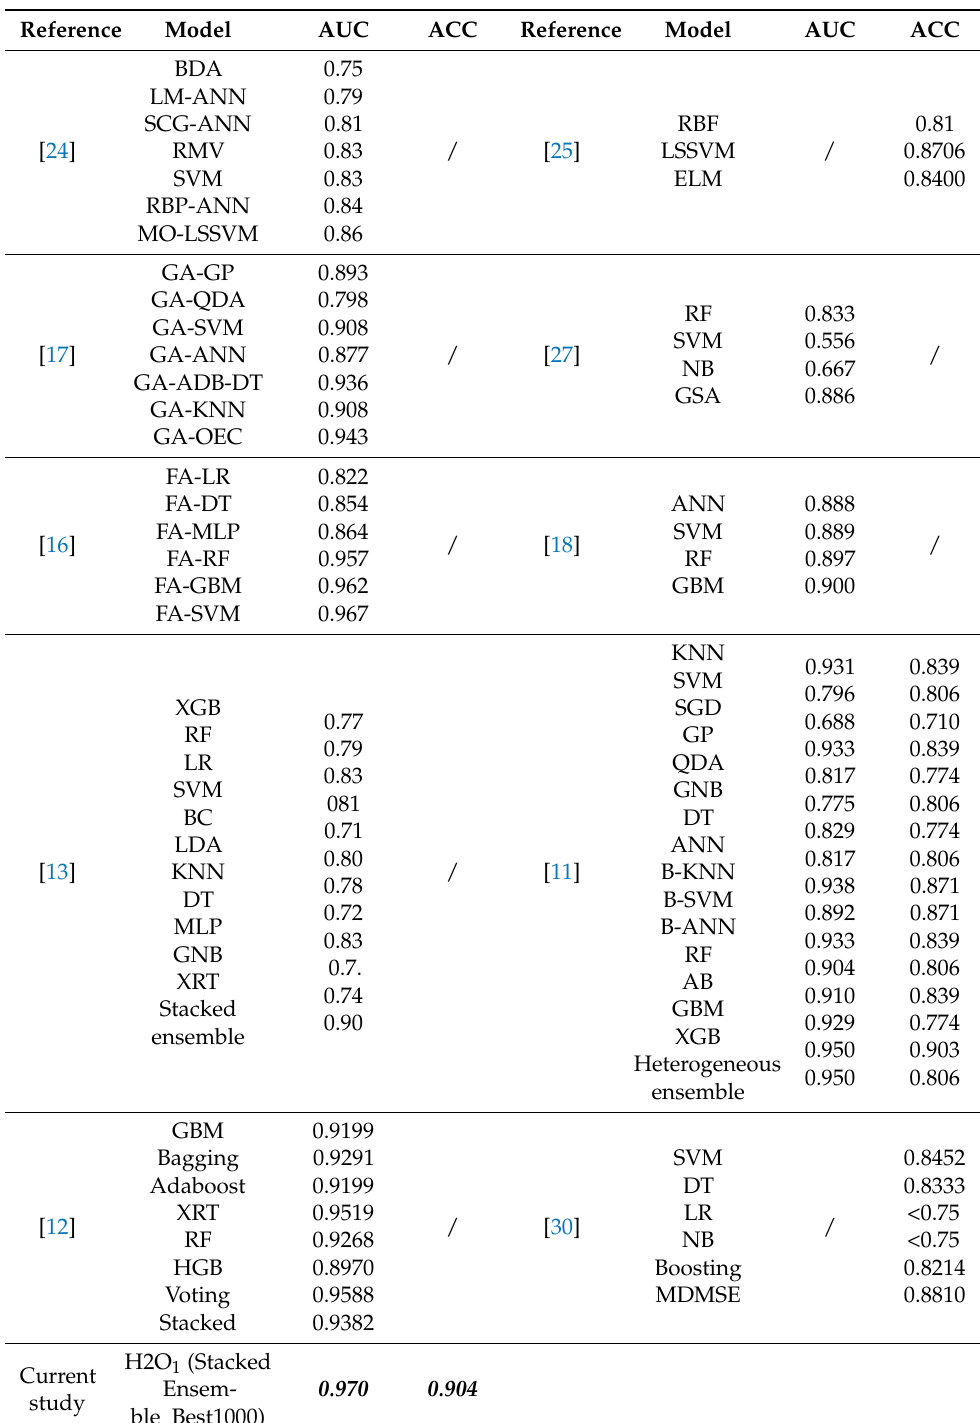
Table 6. Comparison of different ML models for slope stability assessments of circular mode